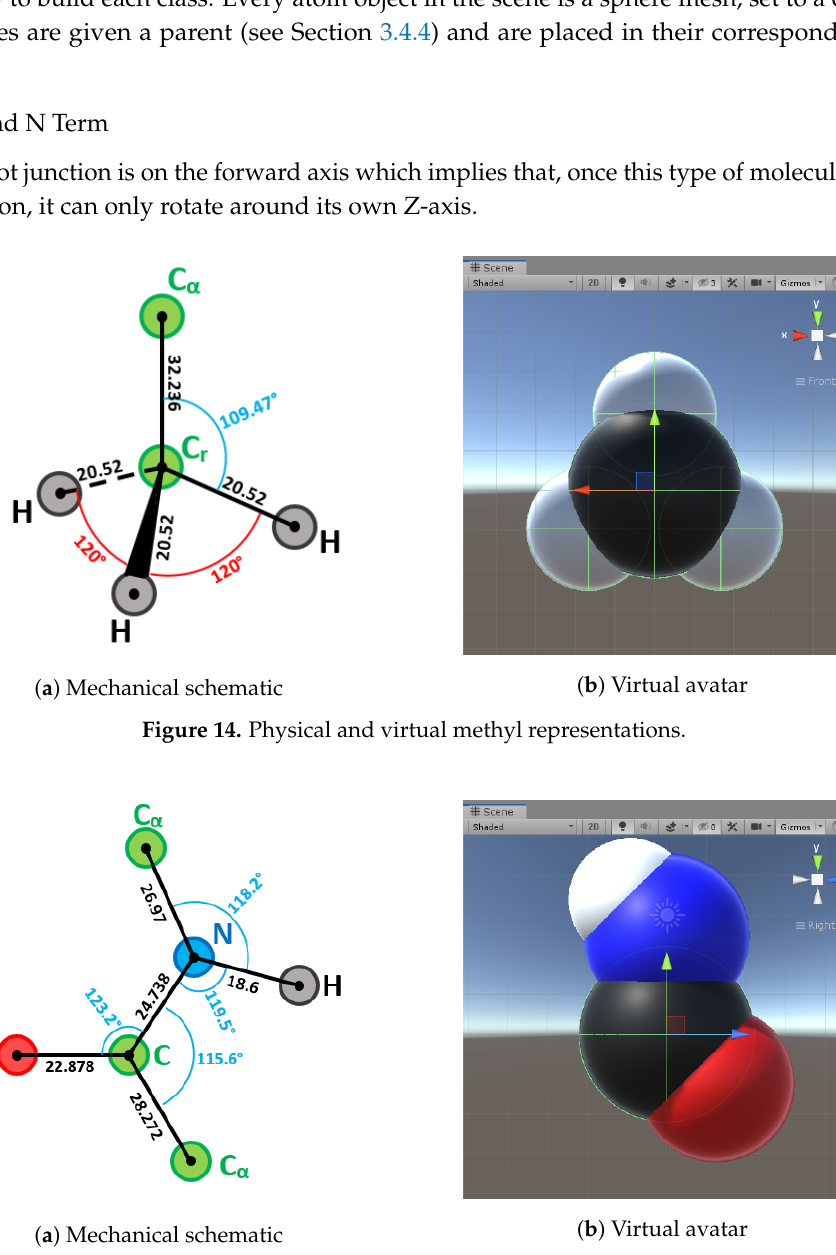
Figure 15. Amide part